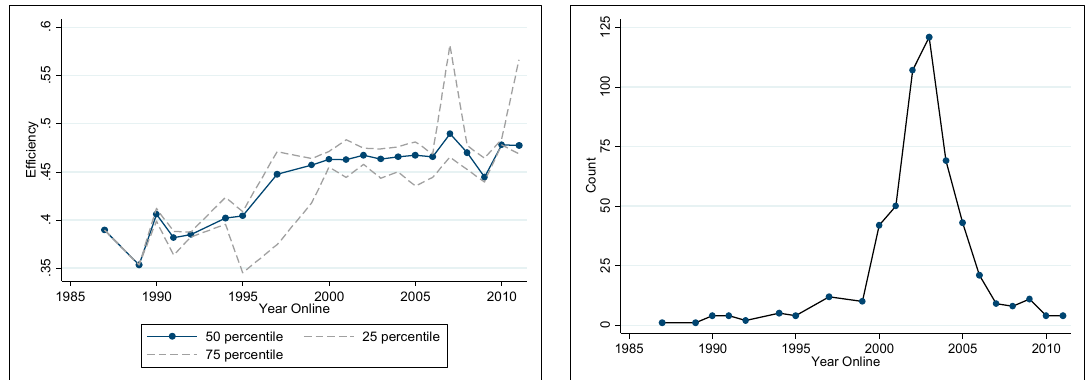
Figure 1. ( Left ) Percentiles for natural gas-fired combined cycle generator (NGCC) plant efficiency based on a sample of NGCC plants in Table 2005. 2007, 2009, and 2012, and organized by the year the plant came online. It is important to note that there were a different number of plants and observations by year online, which is represented as the count of observations ( Right ).